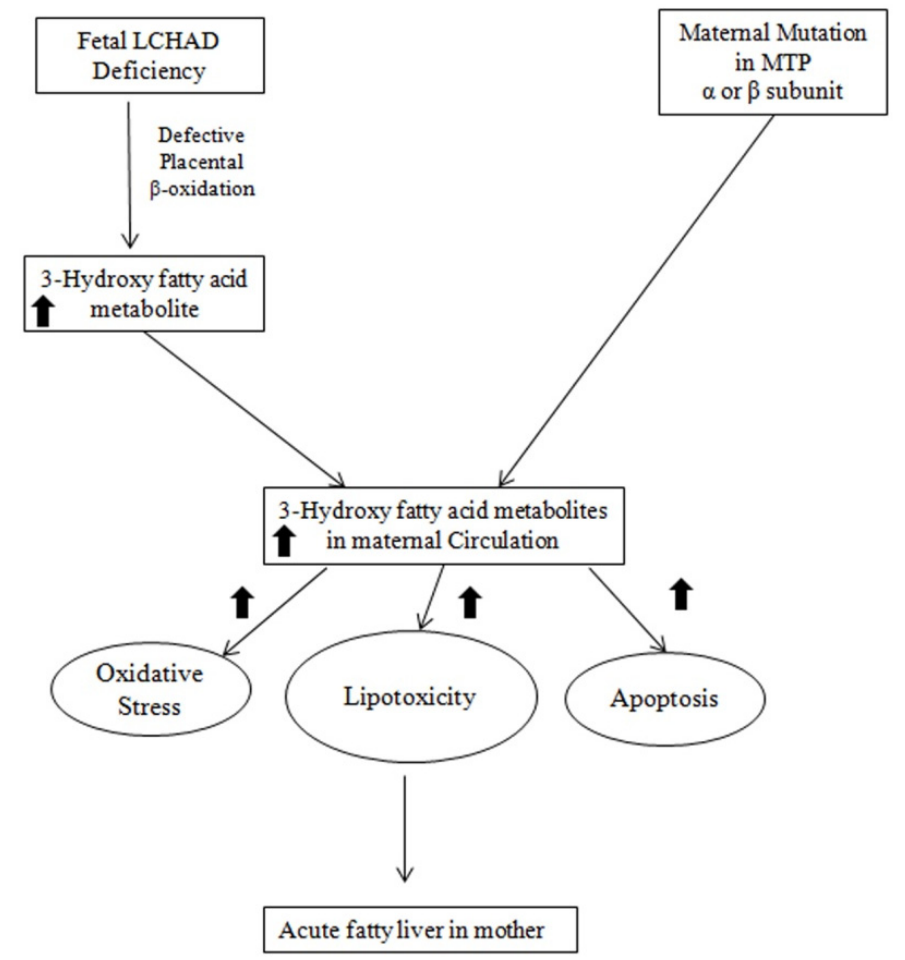
Figure 3. A schematic representation of possible mechanisms leading to the development of mater- nal AFLP associated with fetal LCHAD deficiency. MTP: Mitochondrial Trifunctional Protein; LCHAD: Long chain acyl-CoA dehydrogenase.